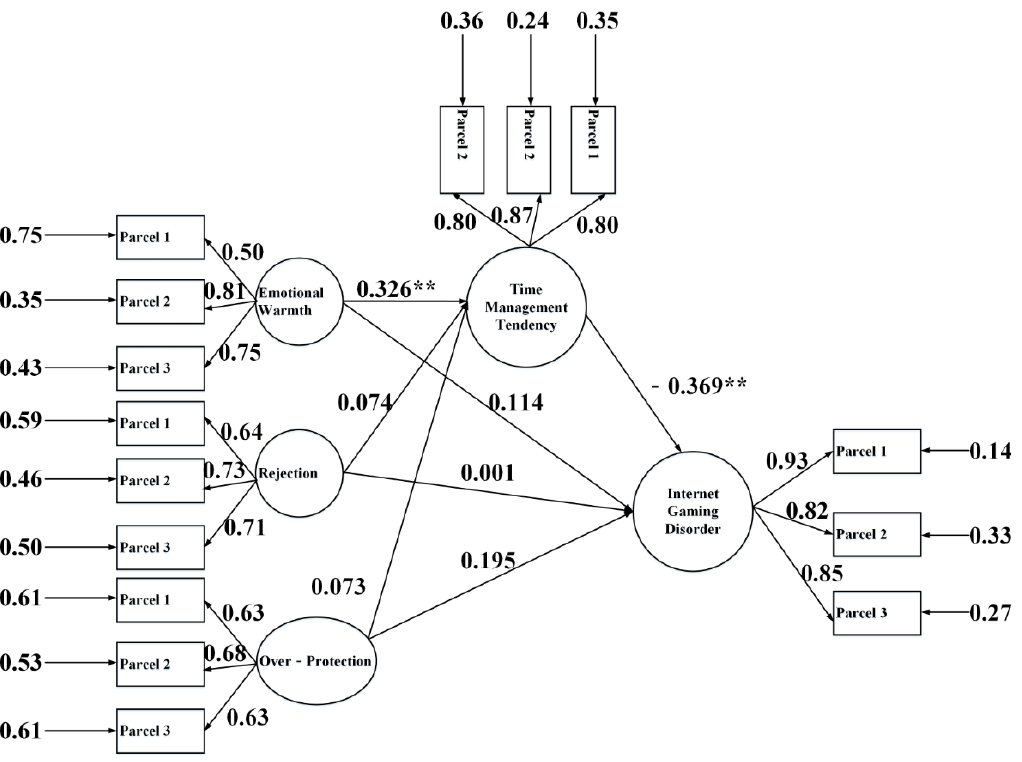
Figure 2. Fathers’ model for mediation analysis. Note: ** p < 0.01.